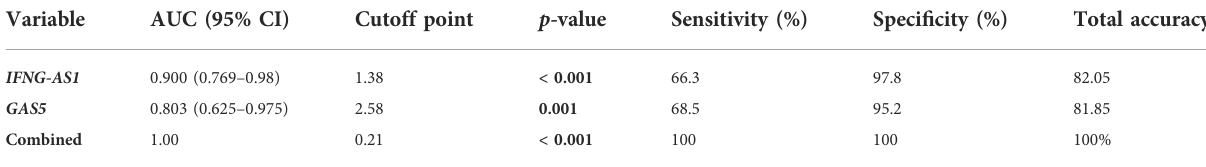
TABLE 5 ROC curve analysis to predict diagnostic values of target genes in differentiating ITP patients from controls.